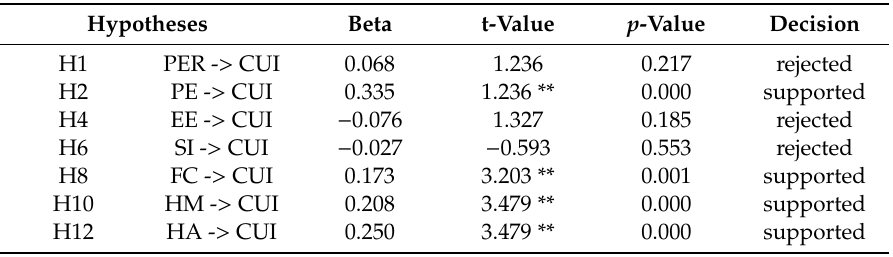
Table 4. Overview of hypothesis testing with direct e ff